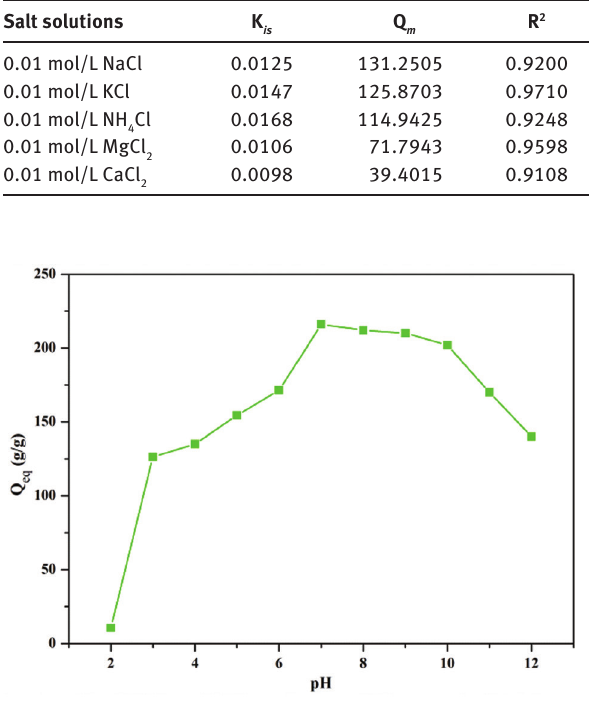
Figure 8: Effect of salt solution on water absorbency of SC-g-PAA/PAM/Urea.